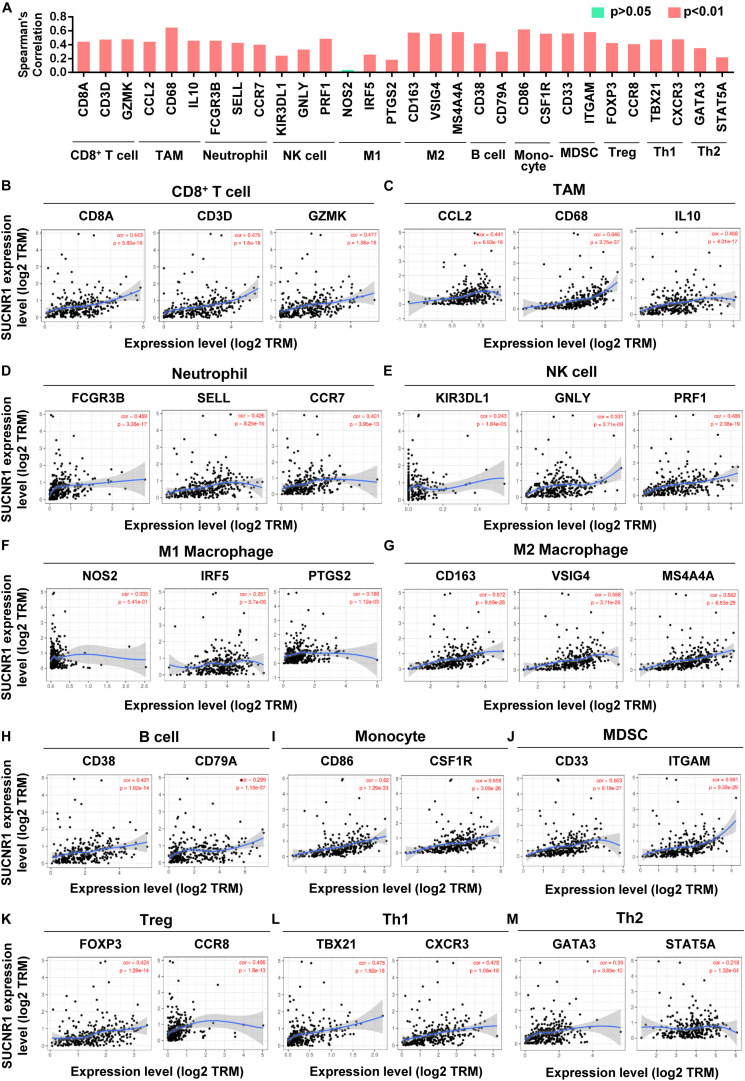
The expression of SUCNR1 is correlated with immune cell markers in ovarian cancer. Markers include CD8A, CD3D, and GZMK of CD8+ T cells; CCL2, CD68, and IL10 of TAM (tumor-associated macrophages); FCGR3B, SELL, and CCR7 of neutrophils; KIR3DL1, GNLY, and PRF1 of NK (natural killer cells); NOS2, IRF5, and PTGS2 of M1 macrophages; CD163, VSIG4, and MS4A4A of M2 macrophages; CD38 and CD79A of B cells; CD86 and CSF1R of monocytes; CD33 and ITGAM of MDSC (myeloid-derived suppressor cells); FOXP3 and CCR8 of Treg (regulatory T cells); TBX21 and CXCR3 of Th1 (T-helper 1 cells); GATA3 and STAT5A of Th2 (T-helper 2 cells). (A) The summary of the correlation between SUCNR1 and immune cell markers. (B–M) Correlation of SUCNR1 expression with immune gene makers of CD8+ T cells (B), TAM (C), neutrophils (D), NK cells (E), M1 macrophages (F), M2 macrophages (G), B cells (H), monocytes (I), MDSC (J), Treg (K), Th1 (L), and Th2 (M) in ovarian cancer are available on the TIMER database. Correlation coefficients (rho values) and p values were shown.